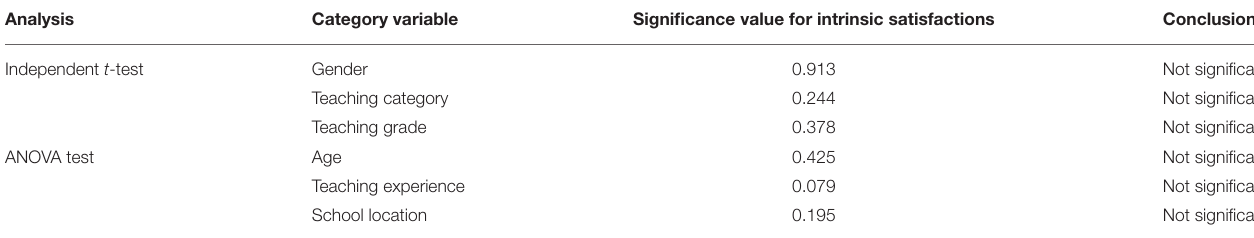
TABLE 6 | Mean difference for intrinsic satisfactions with demographic profile.